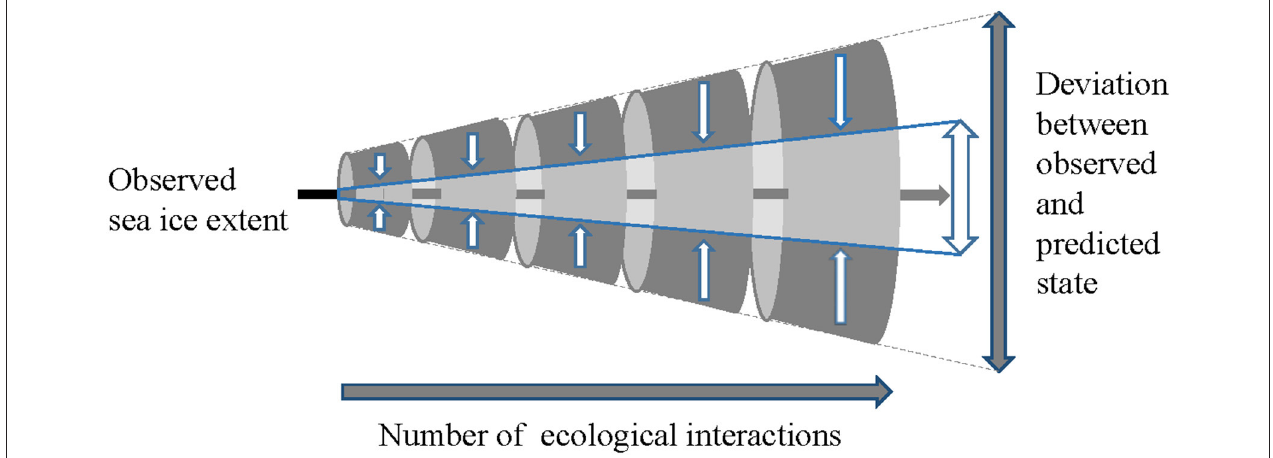
FIGURE 6 | Schematic illustrating that the deviation between observed (actual) and predicted state (in this case sea ice extent) has the potential to amplify as ecological complexity increases. The pale central area and white arrows represent reductions in uncertainty by using the best available models (in this case the eight-model